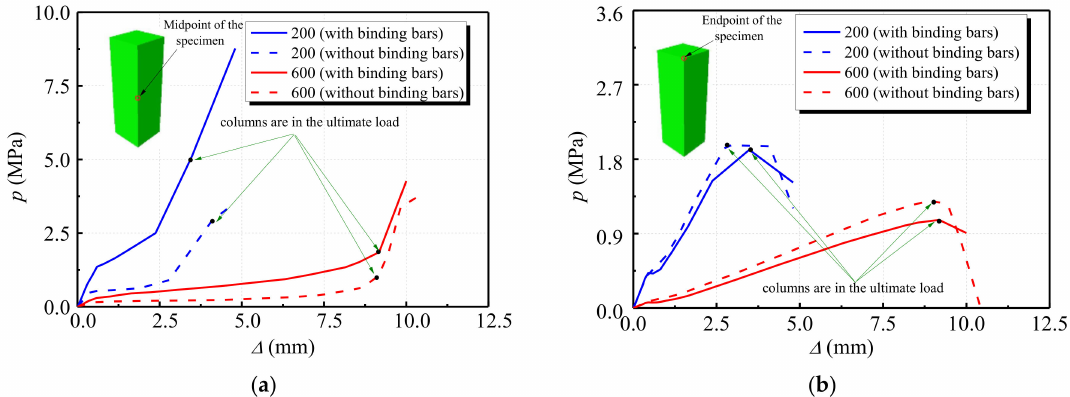
Figure 22. Relationship between restraining force and axial displacement ( a ) middle of column; ( b ) top of